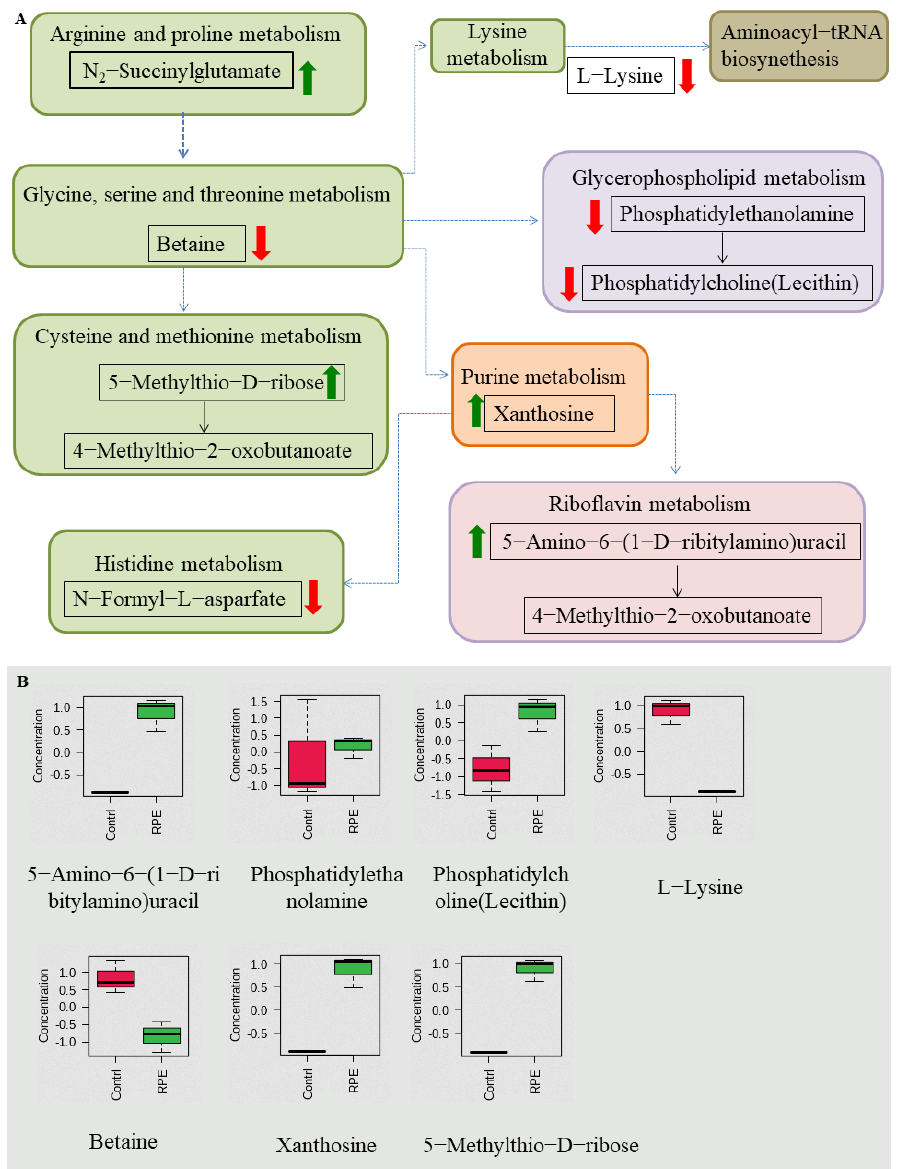
Figure 7. Related metabolic pathways and metabolites with significant changes involved after treatment with RPE treated on MRSA compared to the untreated group. ( A ) Green and red arrows indicate increase and decrease abundance of metabolites, respectively. Different colors in the pathway represent different types of metabolism, while the same color represents the same type of metabolism, e.g., green are all amino acid metabolism. ( B ) Box plots for metabolites with significant changes involved in related metabolic pathways.